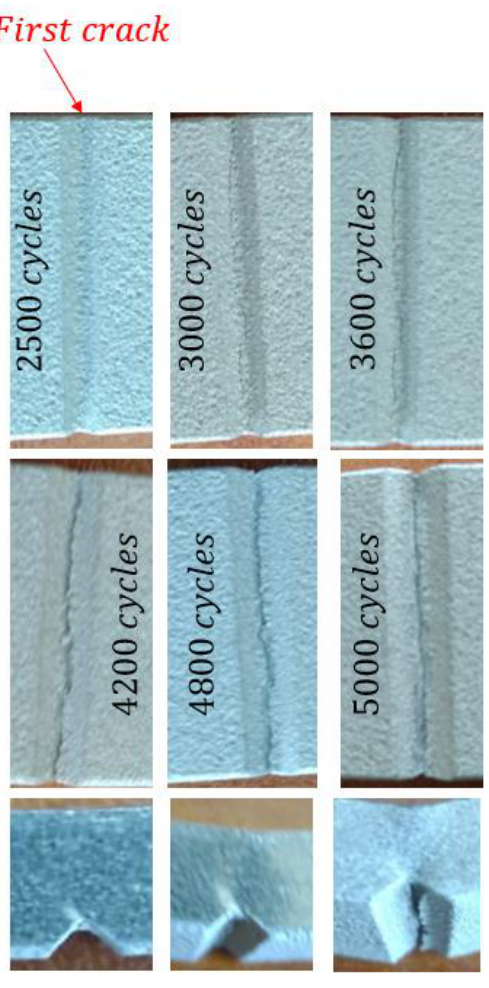
Figure 12. Damage evolution in the coating after different cycles of bending loading at 1.2 mm maximum stroke. As is clear from the pictures, the crack nucleated at the center of the notch without any additional crack at the notch periphery.